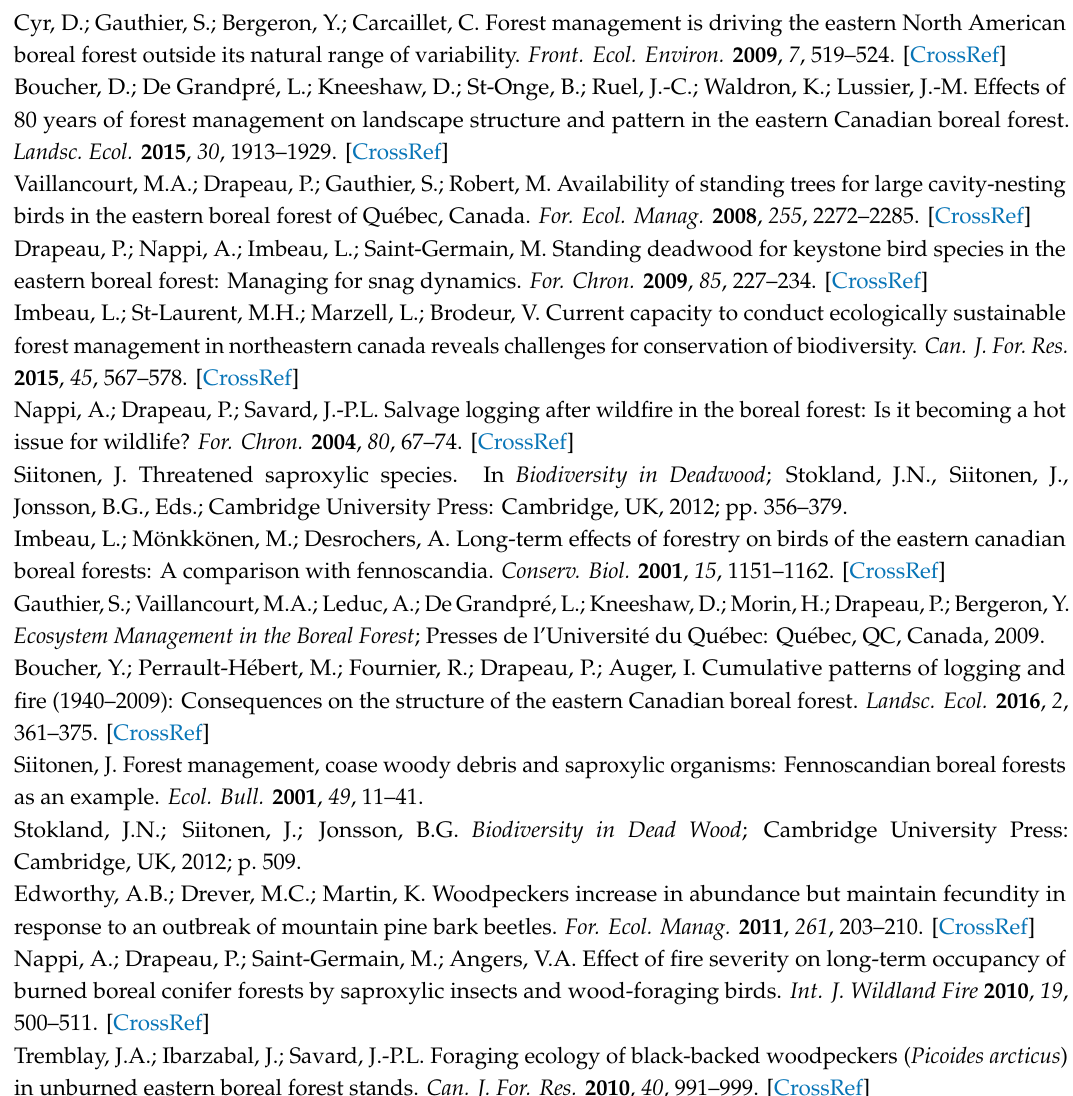
Table S1: Set of biologically relevant candidate models to predict the probability of presence of new foraging marks on girdled trees. The information includes the number of parameters in the model (K), the log-likelihood (LL), the AIC corrected for small samples (AICc), the relative di ff erence in AICc value compared to the top-ranked model ( ∆ AICc), and the Akaike weight ( ω i); Table S2: List of captured saproxylic